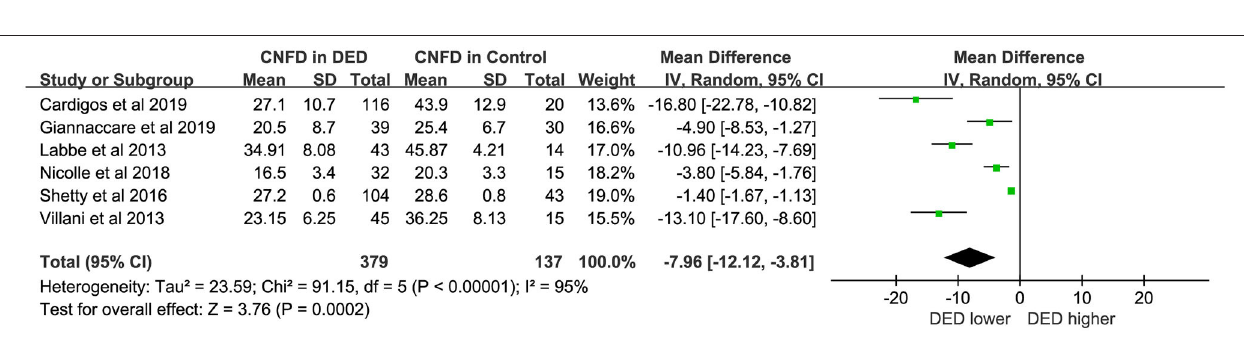
FIGURE 3 | Meta-analysis forest plot of CNFD in DED patients vs. control